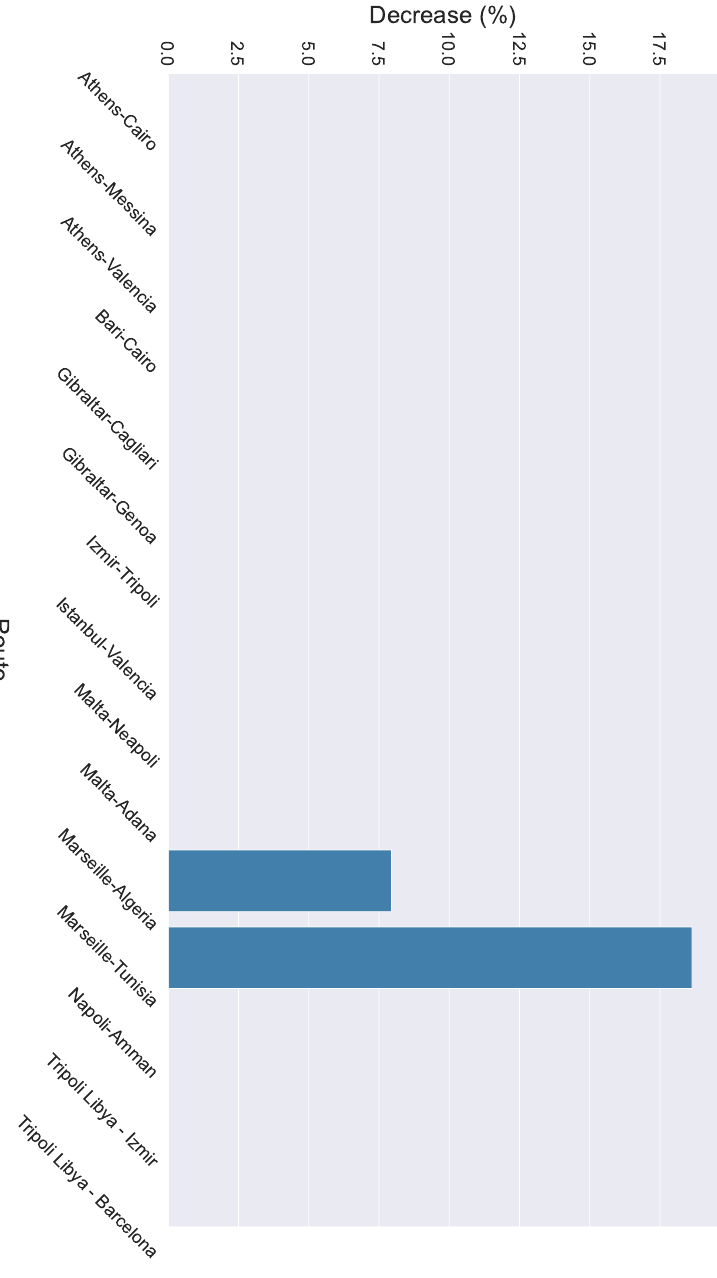
Figure 8. Decrease of the wind speed when the alternate routes are followed. Similar to the previous thresholds, the mean direction of the relative difference between the vessel’s heading and the wave’s direction was measured in both routes (initial and alternate). As the denominator, the mean wave direction of the initial route was used and the difference in the wave direction of the routes was used as the numerator. As a result, the percentage-wise deviation of the wave direction between the routes is illustrated